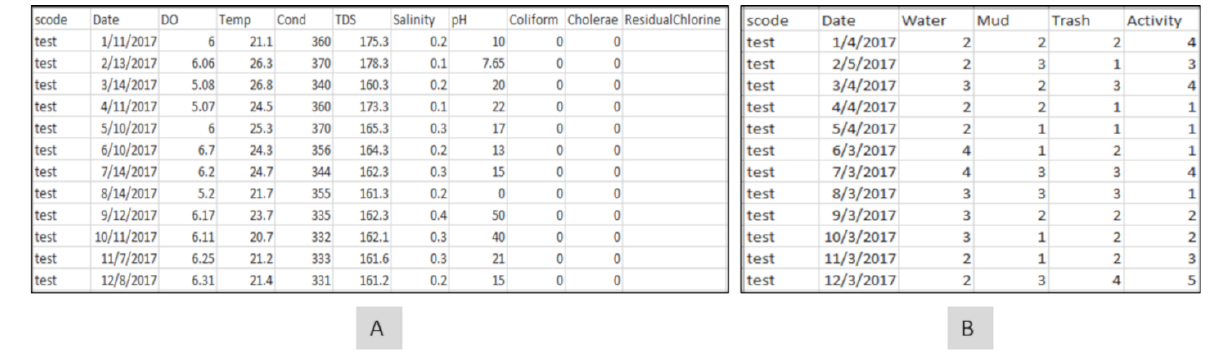
Figure 2. Sample database records for ( A ) experimental and ( B ) environmental records.